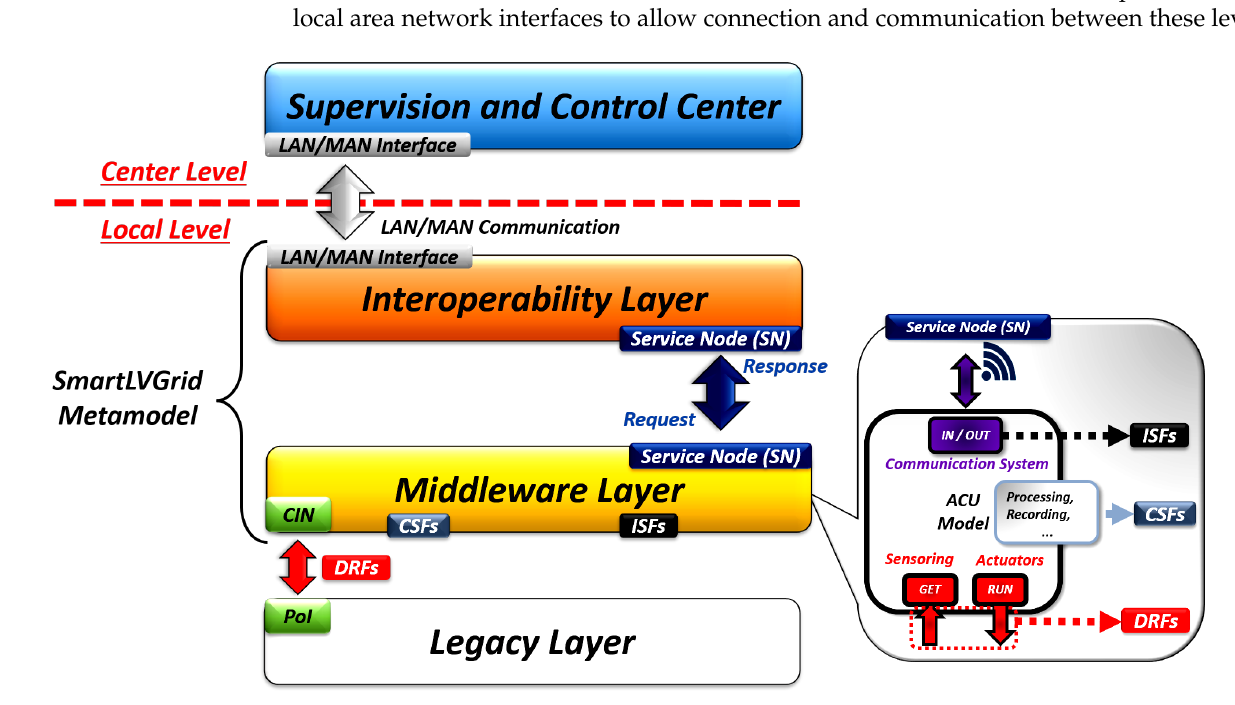
Figure 1. SmartLVGrid